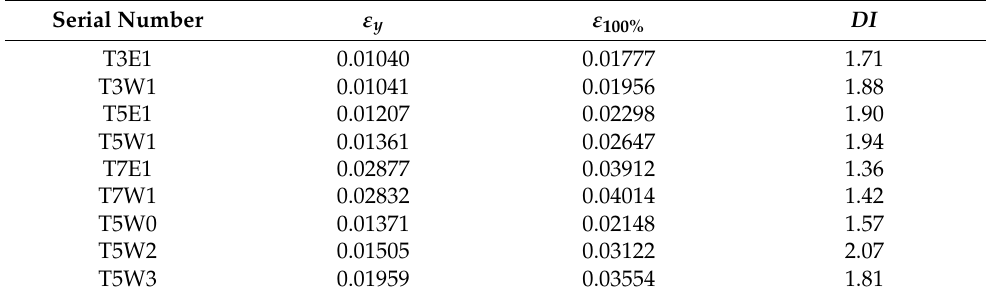
Table 5. Ductility coefficient of specimens and comparison.